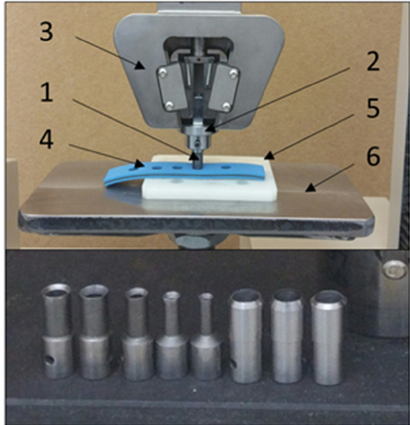
Figure 3. Test stand used to measure the perforation force along with the set of tools used in the experiments: 1—piercing punch, 2—punch chuck, 3—strength testing machine gripper, 4—belt specimen, 5—reducer plate, 6—base.